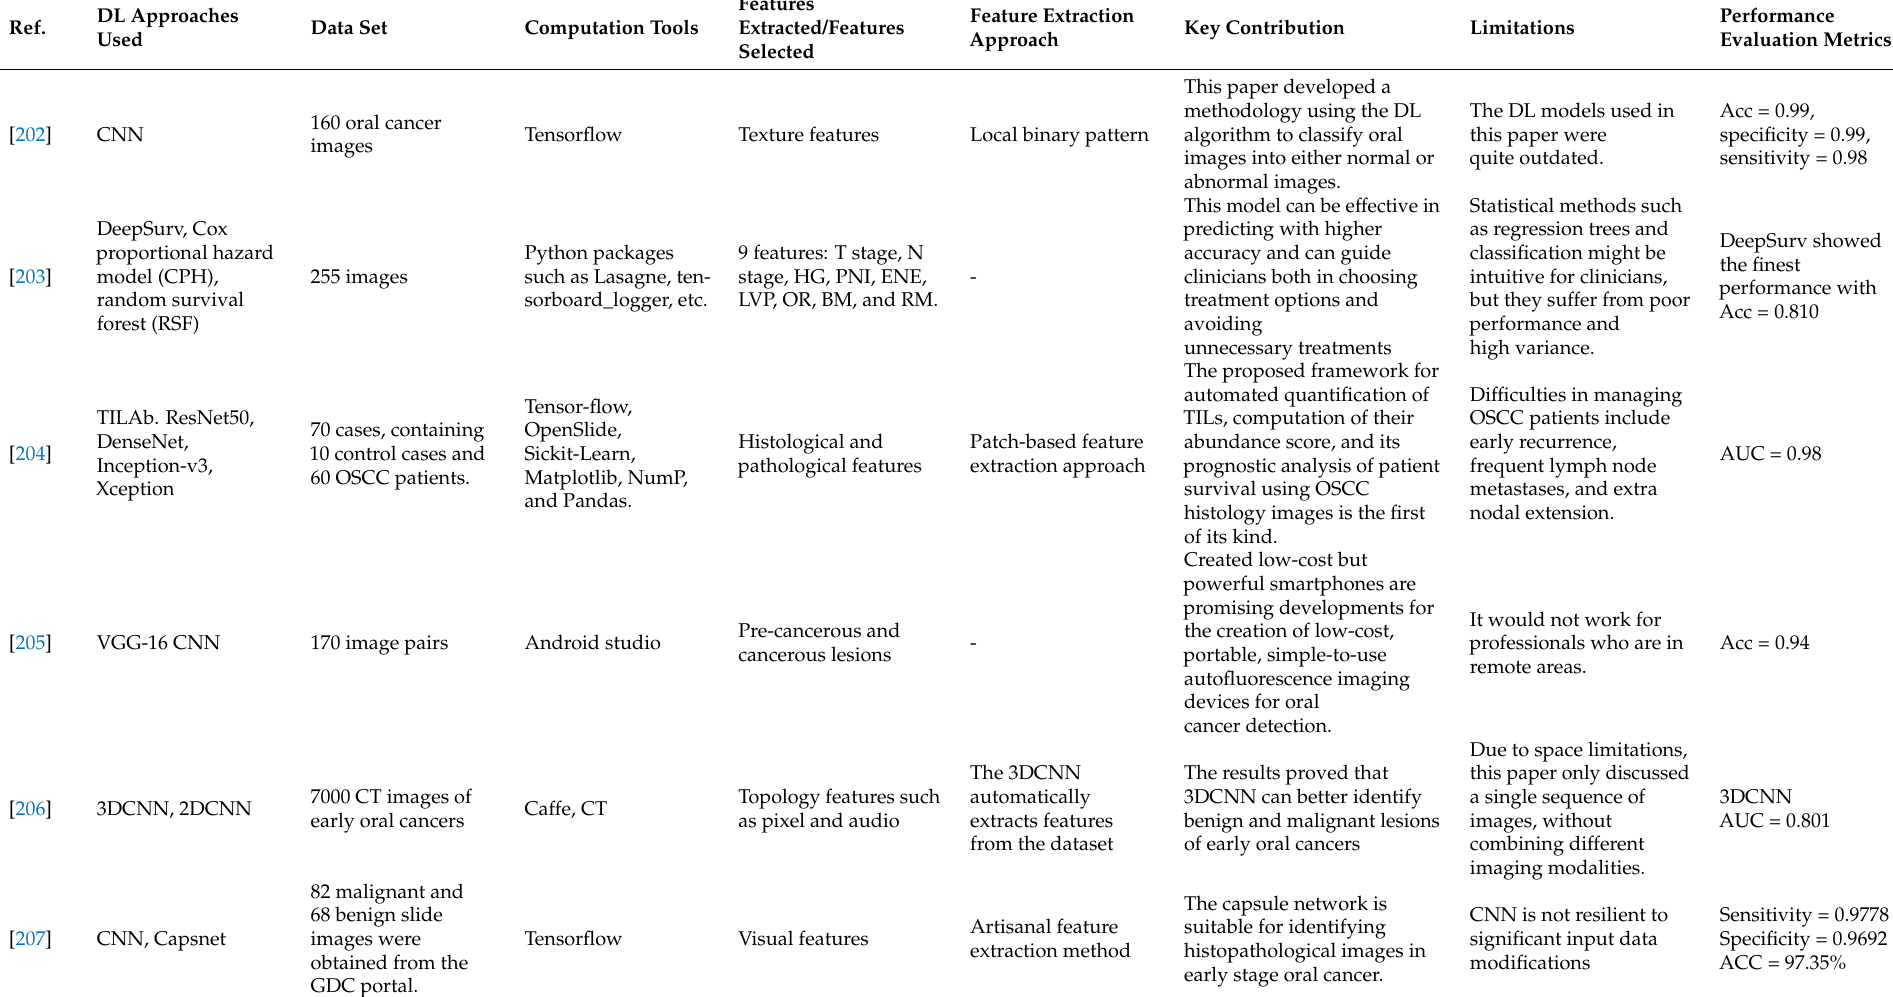
Table 4. A list of articles on DL models for oral cancer